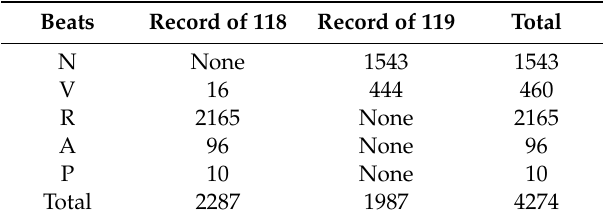
Table 1. Heartbeat distribution after the ECG segmentation.